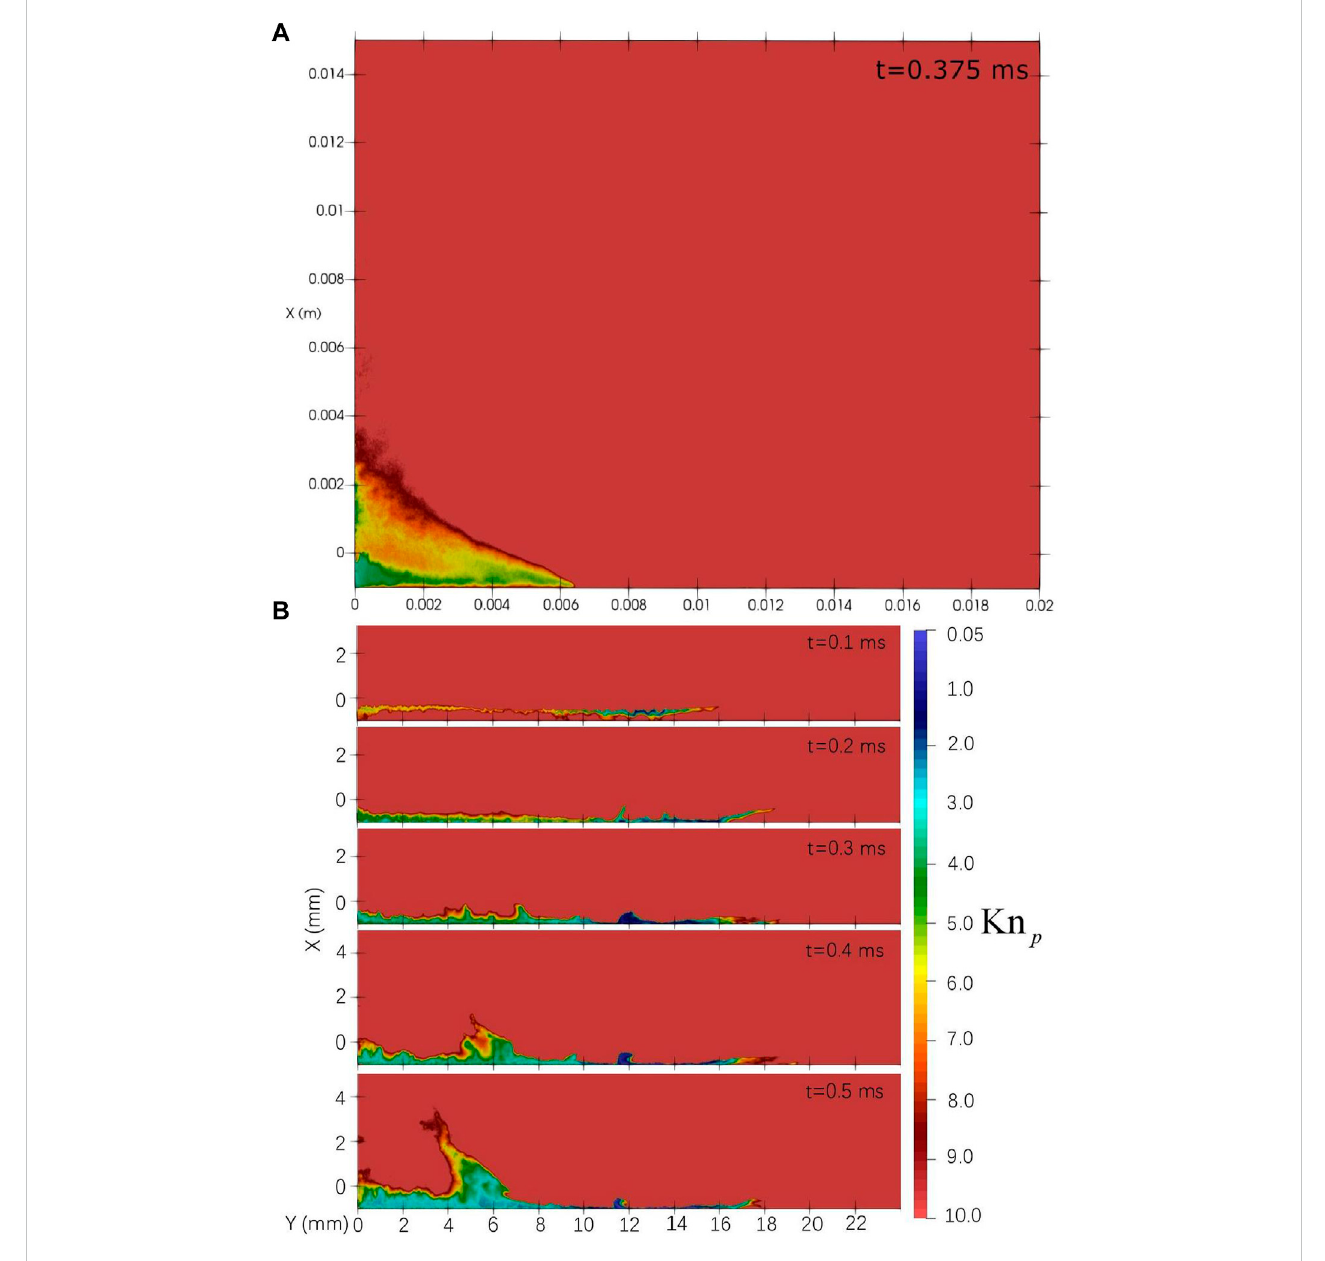
number effects, which would result in inaccuracies in the calculation of the drag force on regolith particles and the subsequent particle trajectories. Hence, the Reynolds number and the Knudsen number effects should be added into the Kamath model Kamath et al. (2022) using corrected drag coef fi cient or adding another coef fi cient into the drag force calculation. In addition, to be more accurate, the Kamath model Kamath et al. (2022) can be extended to account for electrostatic forces caused by charging during interparticle contacts. In addition, an appropriate interphase coupling method (i.e. a method for calculating the momentum and heat transfer between gas and solid particles) should be added because the gas fl ow and the solid particles are in fl uencing each other during the interactions. Additionally,